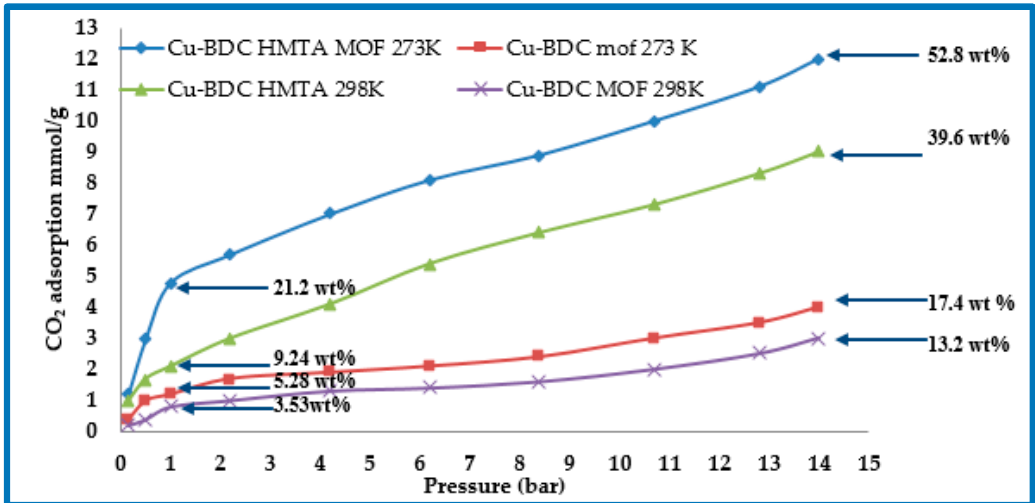
Figure 6. CO 2 adsorption isotherms for Cu-BDC and Cu-BDC ⊃ HMTA at 273 K and 298 K, as